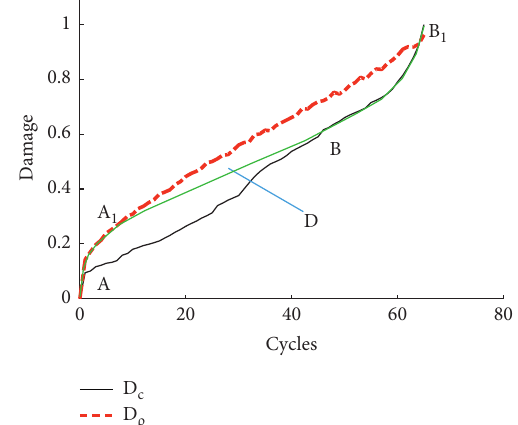
Figure 10: Comprehensive damage